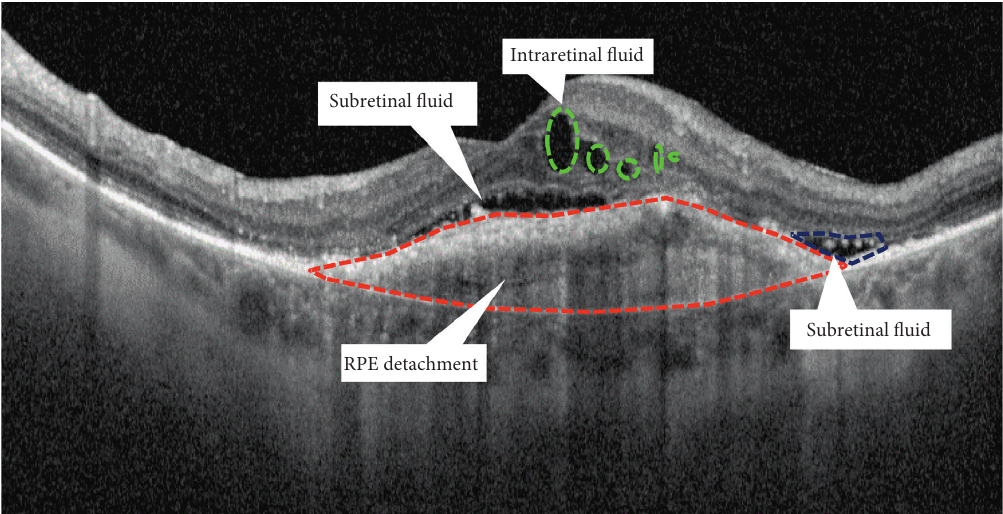
Figure 1: Fluid distribution in neovascular